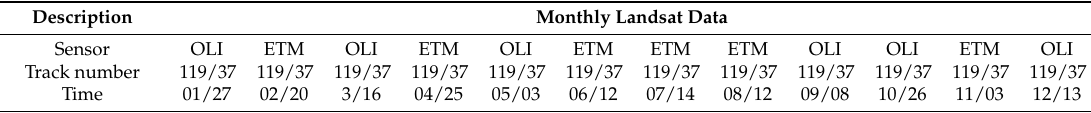
Table 1. Information on the Landsat images used in this study.